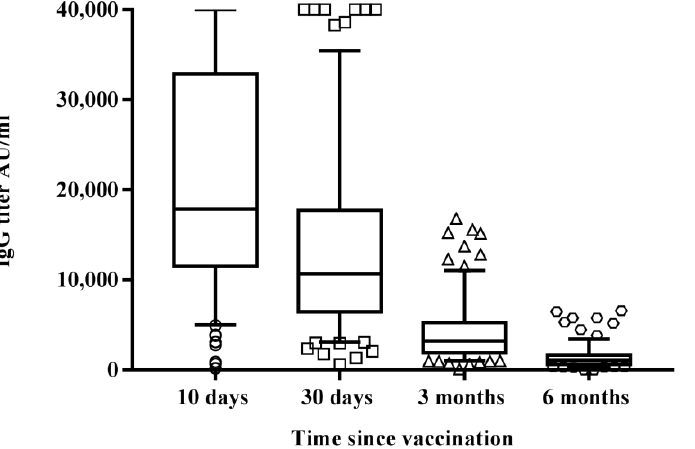
Figure 1. Differences in circulating IgG antibodies between the different time samplings after re- ceiving the second vaccine administration reported as IgG titer in AU/mL. Results are reported in the box-whisker plots as median IgG and upper and lower quartiles. Differences in antibody titers were evaluated, and the statistical significance was assessed using the two-tailed chi-square test. Results were considered statistically significant at p < 0.05. Analyses were performed by using Graph Pad Prism software (v.7.0). Among the study group, 60 subjects were screened for the presence of specific neutralizing antibodies against SARS-CoV-2, 10 days, 1, 3, and 6 months after the second vaccine administration. The test was performed by assessing the protective activity of the humoral response against the live SARS-CoV-2 virus. Results did not show a significant difference ( p = 0.08) in the antibody response, in terms of GMT 10days (GMT = 108.70) or 30 days (GMT = 91.50) after vaccination (Figure 2). However, in the following months, the decline of neutralizing antibodies was consistent, with a significant decrease both three months (GMT = 32.4; p < 0.0001 vs. 30 days) and six months (GMT = 17.5; p < 0.0001 vs. three months) after the vaccine administration.